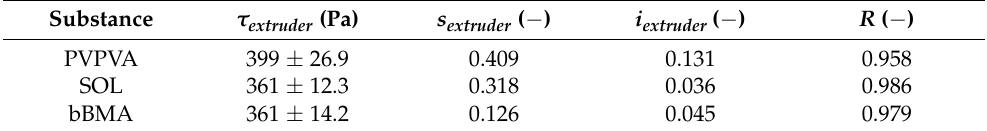
Table 2. Model parameters for autogenic extrusion (Equations (10) and (11)). Specific to a particular extruder in a certain setup (av ± s), independent form material and process